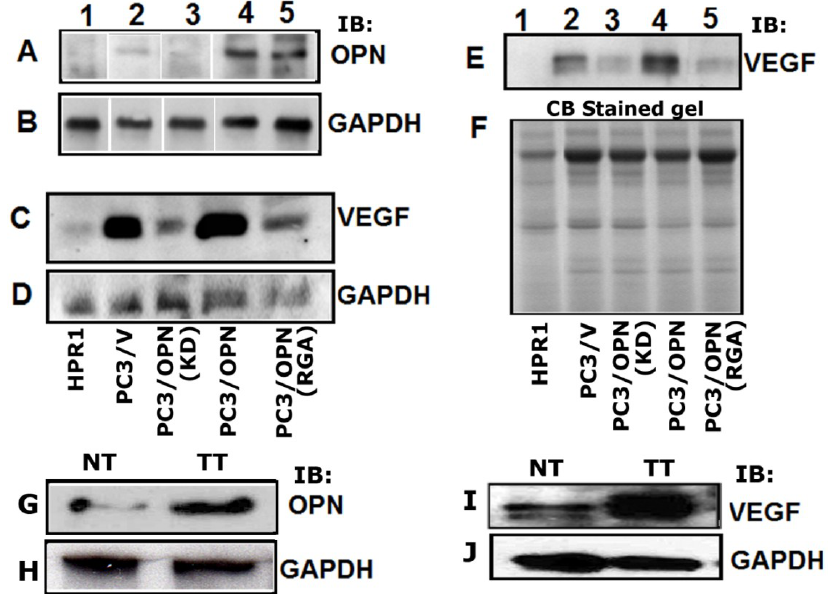
PC3 cell lines was used for immunoblotting analysis with an antibody to OPN ( A )